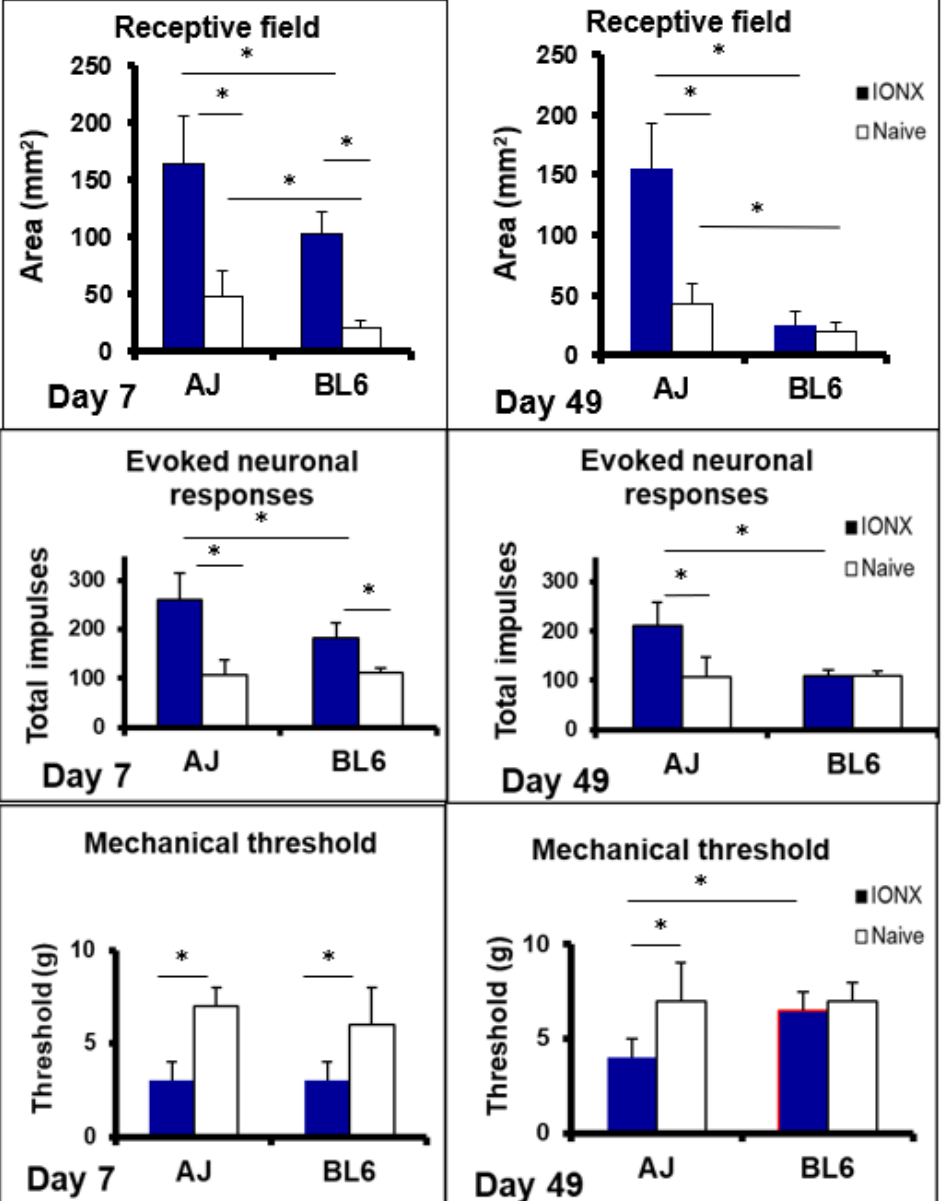
Figure 6. Infraorbital nerve injury in the mouse induces trigeminal central sensitization that is genetically dependent. A/J (AJ, n = 12) and C57BL/6J (BL6, n = 12) male mice aged 8–12 weeks were maintained under similar environmental conditions, and used for electrophysiological recordings made in histologically identified sites in the medullary dorsal horn. A total of 40 nociceptive neurons functionally classified as nociceptive-specific neurons was recorded. At 7 days or 49 days prior to the recording experiment, animals received unilateral transection (IONX) of the medial branch of the infraorbital nerve or no IONX (i.e., naïve rats). IONX-induced trigeminal central sensitization of the neurons was expressed as significant increases (compared to naïve) in neuronal mechanoreceptive field size and responses evoked by graded mechanical stimulation and a significantly decreased mechanical activation threshold (ANOVA, p < 0.05). Note the significant differences between A/J and C57BL6 mice in the magnitude and time course of these three parameters of trigeminal central sensitization following IONX (2-way ANOVA, p < 0.05). Central sensitization was evident at post-operative day 5 in both A/J and C57BL6 mice but at post-operative day 49 it was only present in A/J mice. Note in addition that naïve animals also showed a significant difference between A/J and C57BL6 mice in mechanoreceptive field size. * p < 0.05. Based on data from Varathan et al. [121] and Cherkas et al. [168].